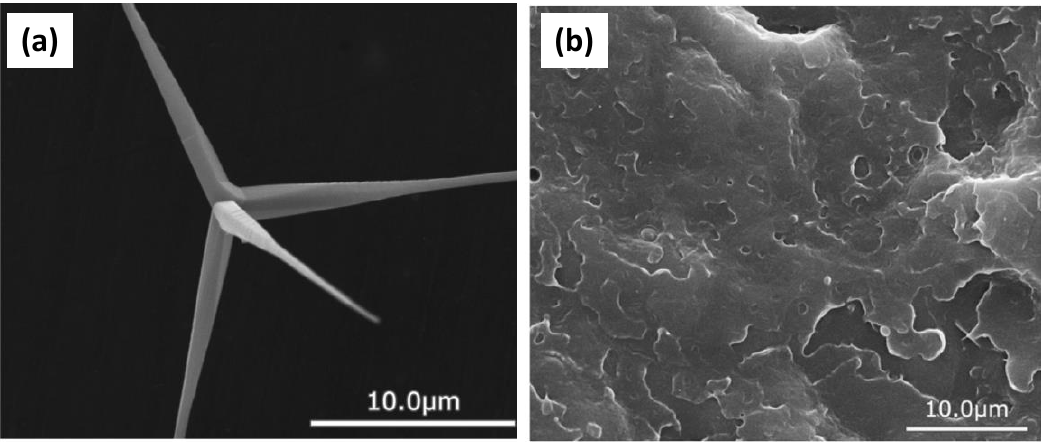
Figure 10. Typical SEM microphotograph of ( a ) a T-ZnOw whisker and ( b ) impact-fractured surfaces of composites with untreated T-ZnOw. Images from [20].